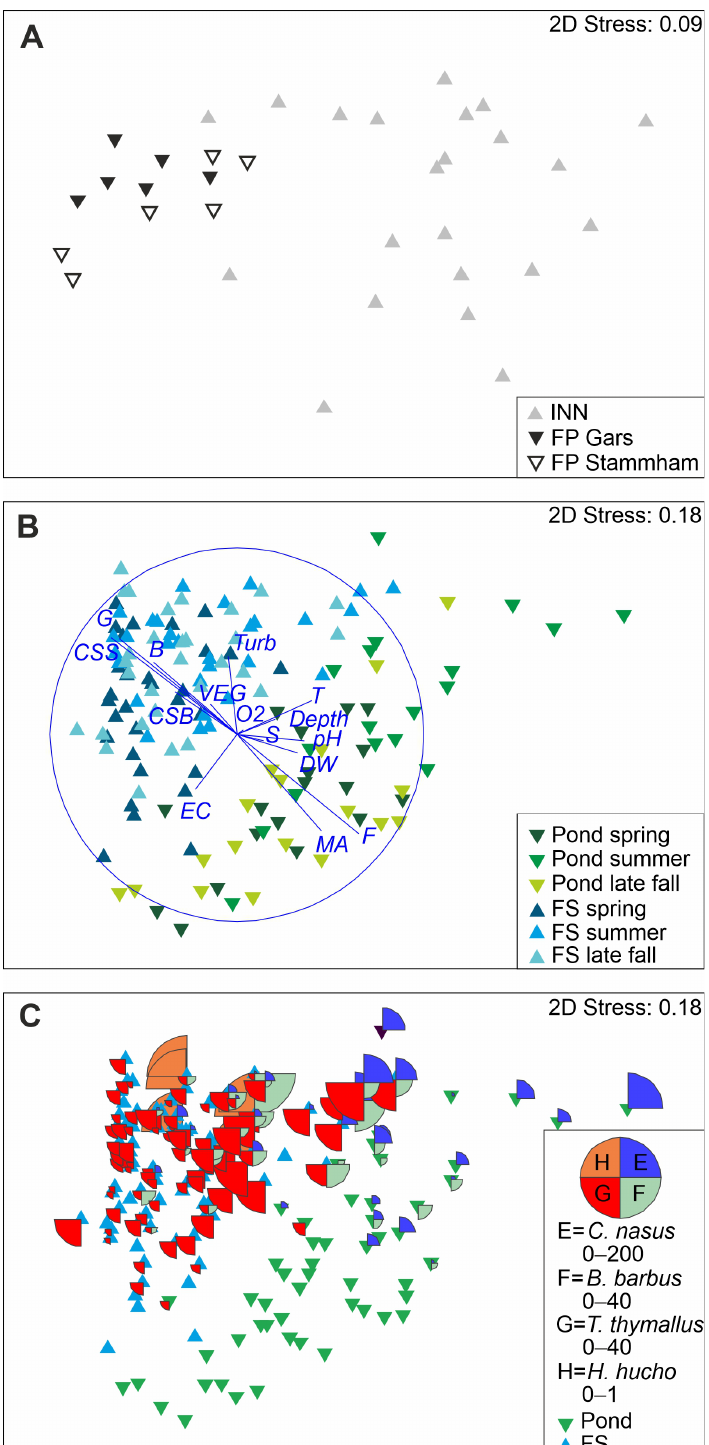
Figure 4. Non-metric multidimensional scaling (nMDS) comprising comparisons of fish community composition based on catch per unit effort (CPUE) abundance data. ( A ) The River Inn and the fish passes (Inn = grey triangles, black triangles, = fish pass Gars, open black triangles = fish pass Stammham), ( B ) comparison of the fish community composition in ponds (green triangles) versus fluvial habitats (blue triangles), and ( C ) proportion of target species in ponds or fluvial habitats displayed as pie size. Green triangles (ponds) and blue triangles (fluvial habitats). C. nasus = Chondrostoma nasus , B. barbus = Barbus barbus , T. thymallus = Thymallus thymallus , and H. hucho = Hucho hucho . Abbreviation of habitat variables refer to Tables 2–4. Turb = turbidity in NTU. 2D-Stress = stress value after